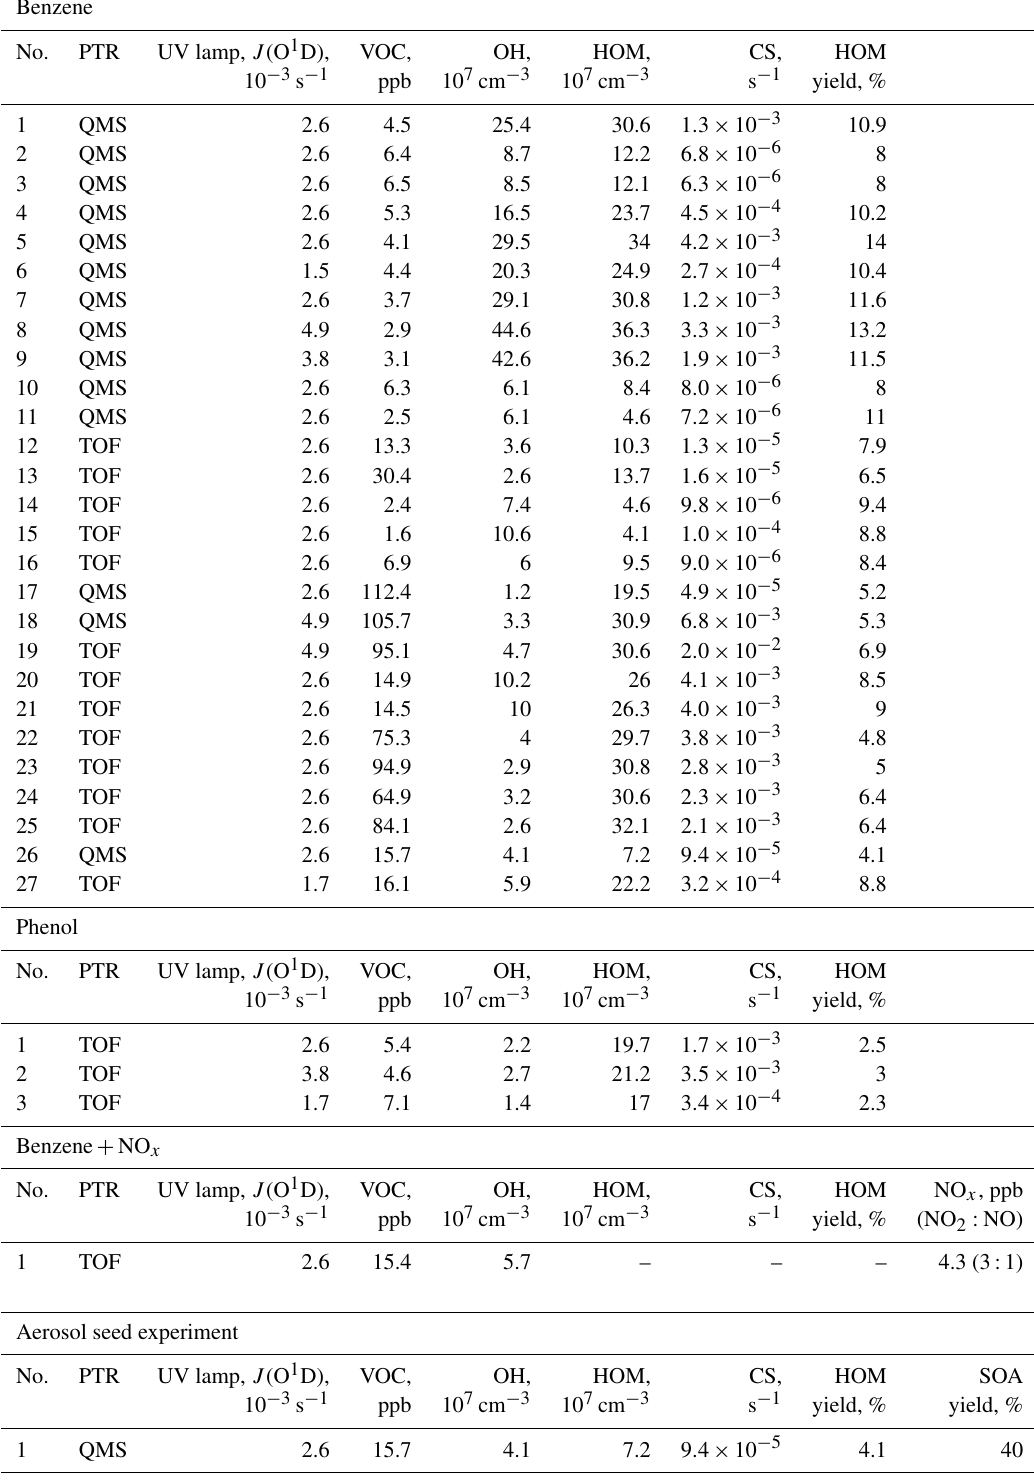
Table 1. Summary of the experimental parameters from the JPAC chamber. QMS/TOF refers to the quadrupole/time-of-flight detector in the proton transfer reaction (PTR) mass spectrometer used for measuring VOCs.